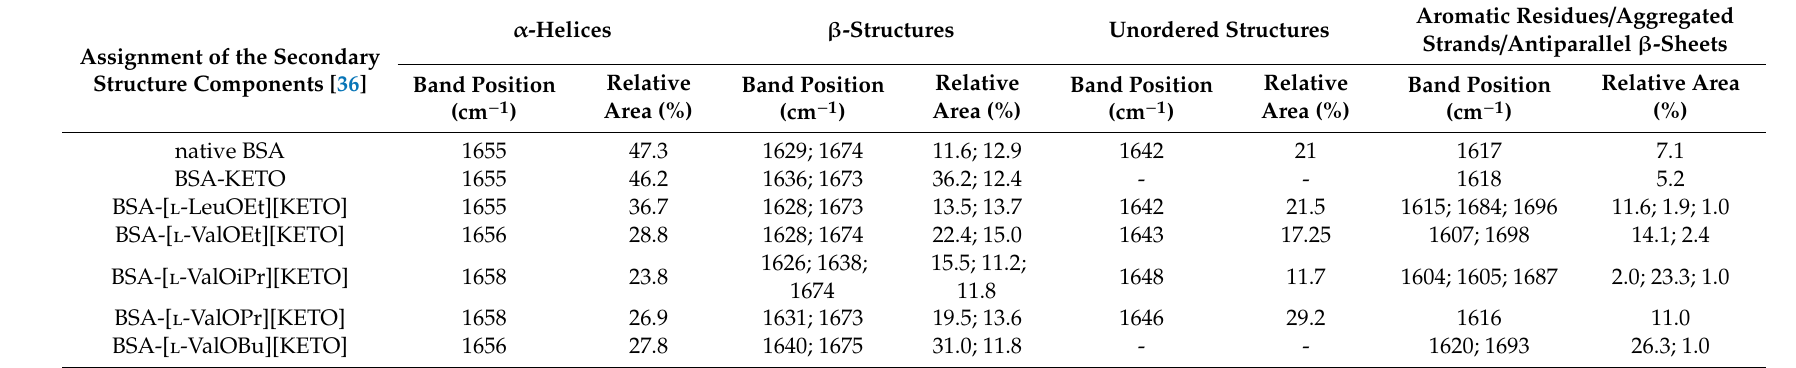
Aromatic Residues / Aggregated Strands / Antiparallel β